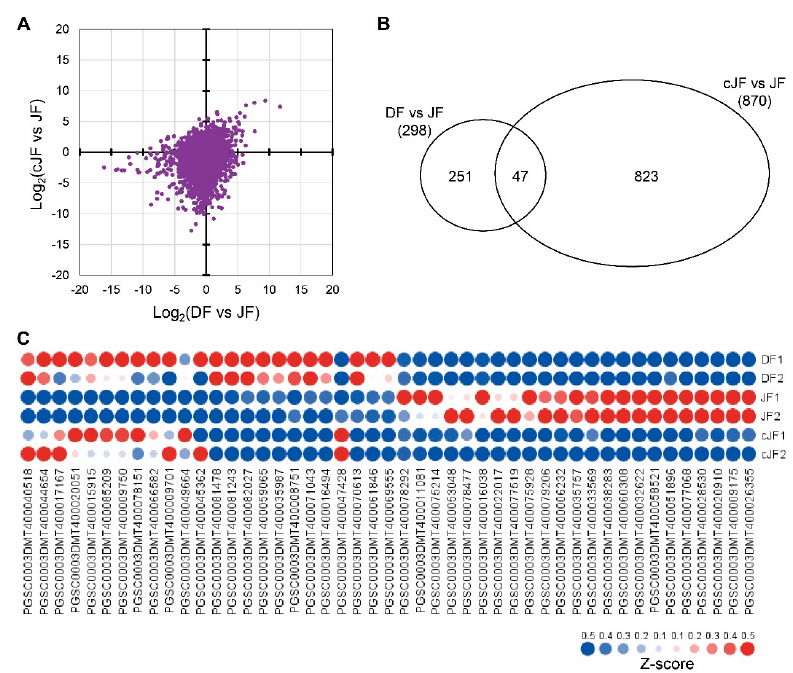
Figure 3. DEG (differentially expressed genes) analysis of DF, JF, and cJF identified 47 genes. ( A ) Expression patterns in dot plot. The x axis indicates log 2 value of TPM (transcripts per million) in DF divided by TPM in JF for each gene, and the y axis indicates log 2 value of TPM in cJF divided by TPM in JF for each gene. ( B ) Venn diagram depicting common and specific DEGs. ( C ) Heatmap of common DEGs. Z-score for each gene was used. Numbers in sample names indicate biological replicate number. Using 36 JF-specific DEGs, we performed functional annotation with DAVID GO analysis. Four GO terms in biological processes were enriched: defense response ( p -value